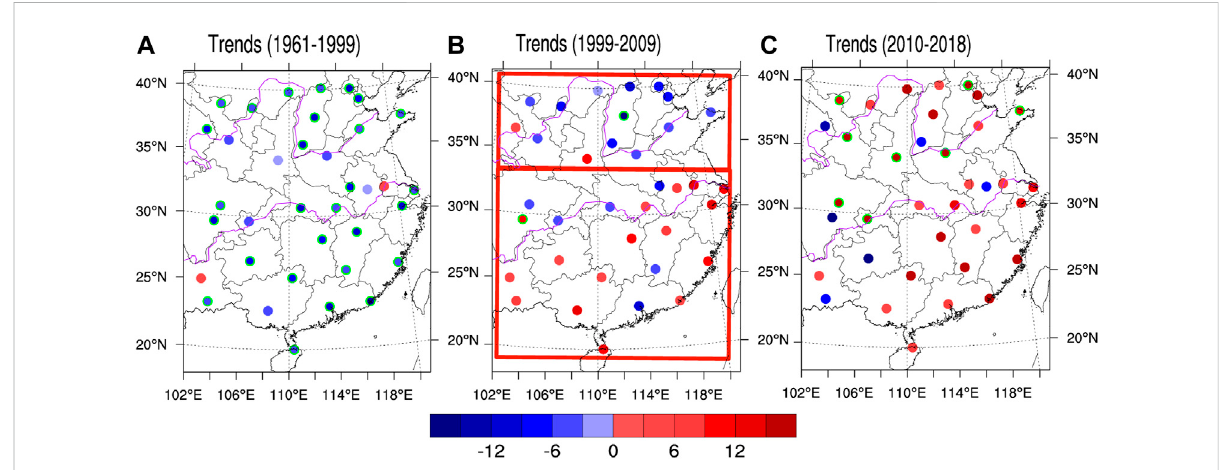
FIGURE 3 GeographicaldistributionofthedecadaltrendsinGSRfortheperiod1961 – 1999 (A) ,1999 – 2009 (B) and2010 – 2018 (C) in36radiationstations in eastern China. (Unit: W m − 2 decade − 1 ). Green circle indicate that trends are statistically signi fi cant at the 95% con fi dence level.